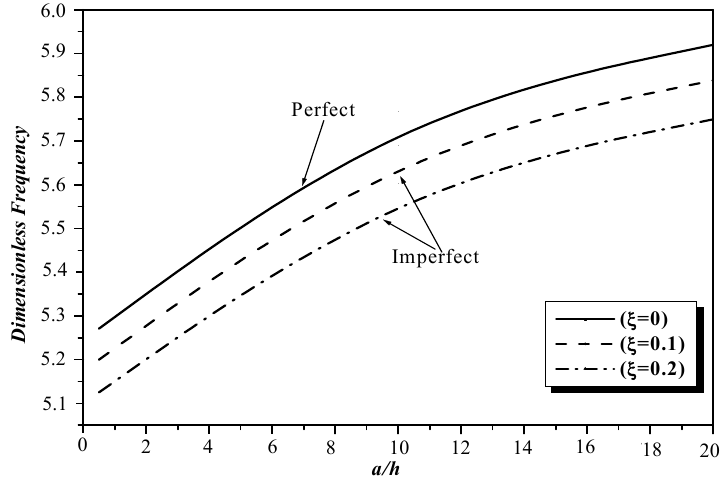
Figure 5. The dimensionless frequency ω vs. the thickness ratio a / h for perfect and imperfect plates.